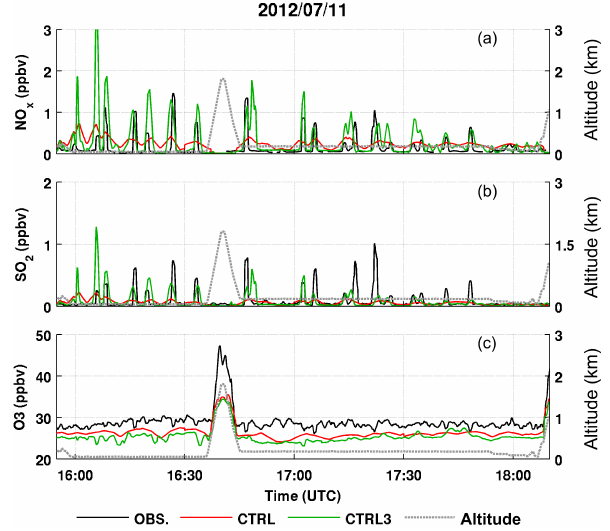
Figure 6. Time series of measured O 3 and NO x on 11 July 2012 compared to model results extracted along the flight track for the CTRL and CTRL3 runs. Observations are in black, the CTRL run is in red, and the CTRL3 run is in green. A 56s averaging window is applied to the measured data for model comparison (approximately the time for the aircraft to travel 2 × 3km). Flight altitude is given as a dashed gray line. After the first run at 49m, a vertical profile was performed (16:35 to 16:45UTC) providing information about the vertical structure of the boundary layer.